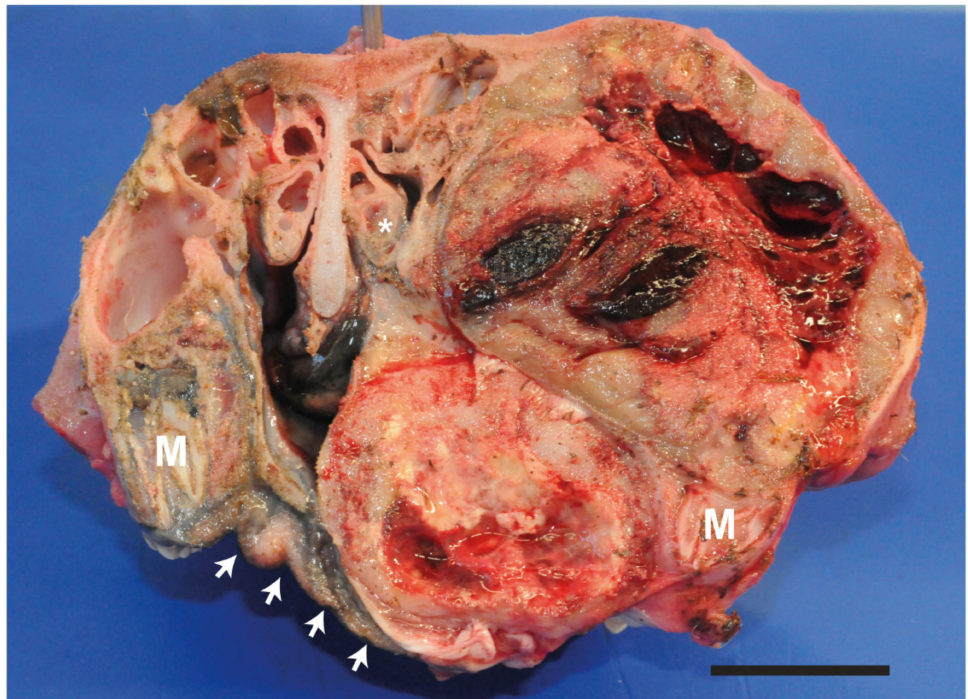
Figure 3. Macroscopical aspect of the suborbital congenital undifferentiated sarcoma upon transversal section at the level of the last molars (rostral aspect). Note that the neoplasm disrupts the morphology of the nasal cavities and of the palate profile (arrows) by squeezing all right nasal meatus and infiltrating the ventral conca (*). Ventrally the neoplasm displaces the palate and slightly the nasal septum to the left. The neoplasm appears multilobular, poorly demarcated, cavitated with multiple haemorrhagic and necrotic areas. M, last molar. Bar 4